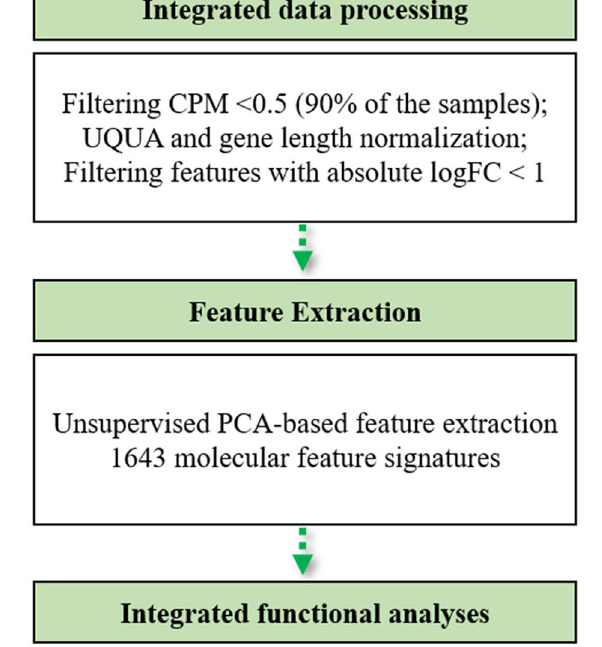
samples were randomly distributed in the two-dimensional space ( Supplementary Figure 2 ). Out of the 1,643 expression signatures, 1,561 were protein-coding genes.